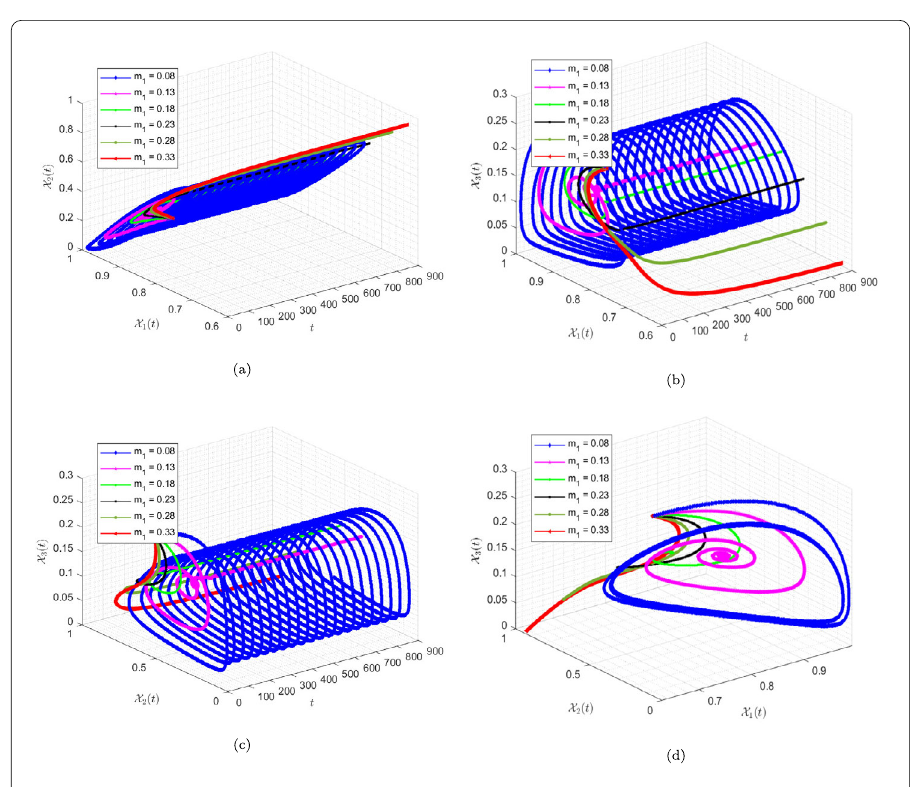
Figure 10 Dynamics for system (19) by taking different values of parameter m 1